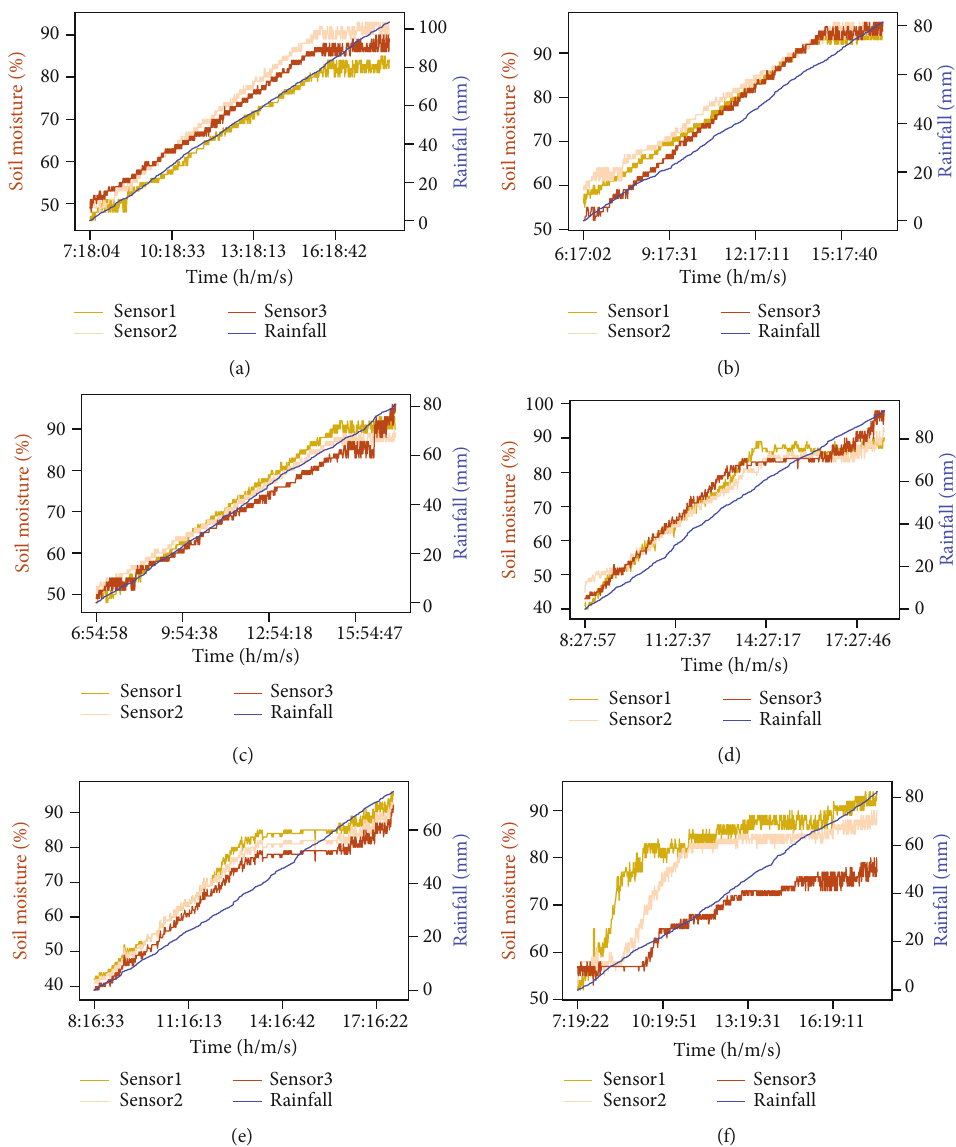
Figure 9: Variation of soil moisture content versus rainfall for three tests on site SC1 (a – c) and site SC3 (d –